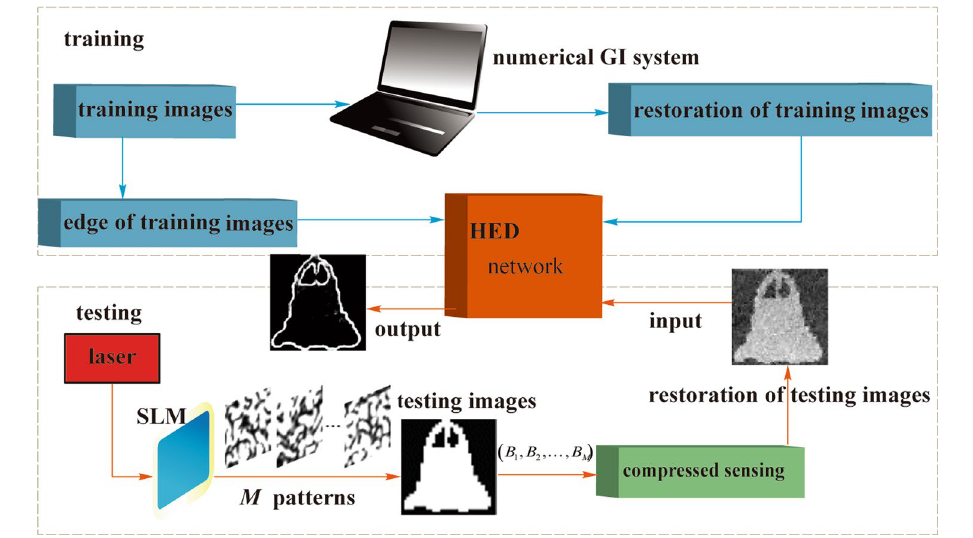
Fig. 1 Schematic diagram of the proposed ghost edge detection scheme with deep